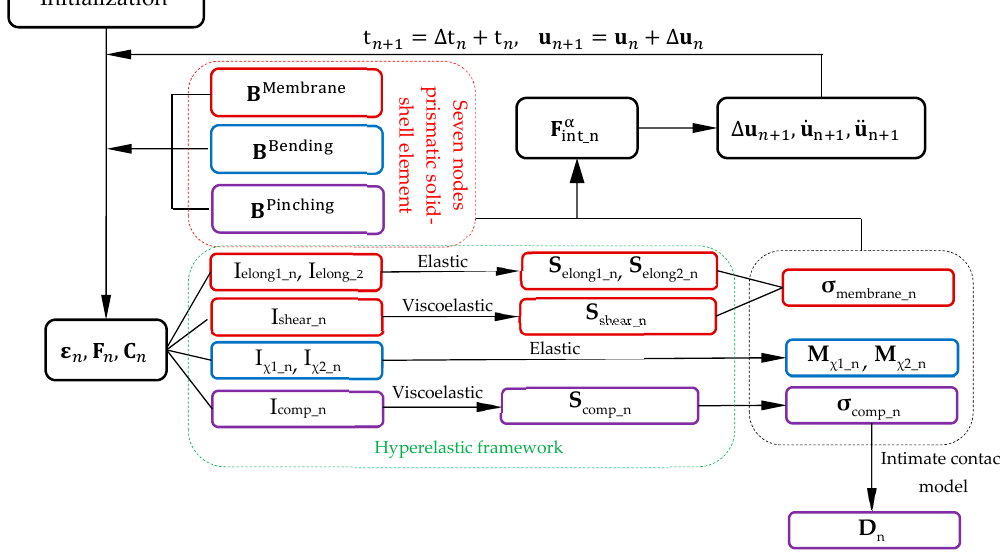
Figure 8. Flowchart of the finite element analysis of the degree of consolidation D n .